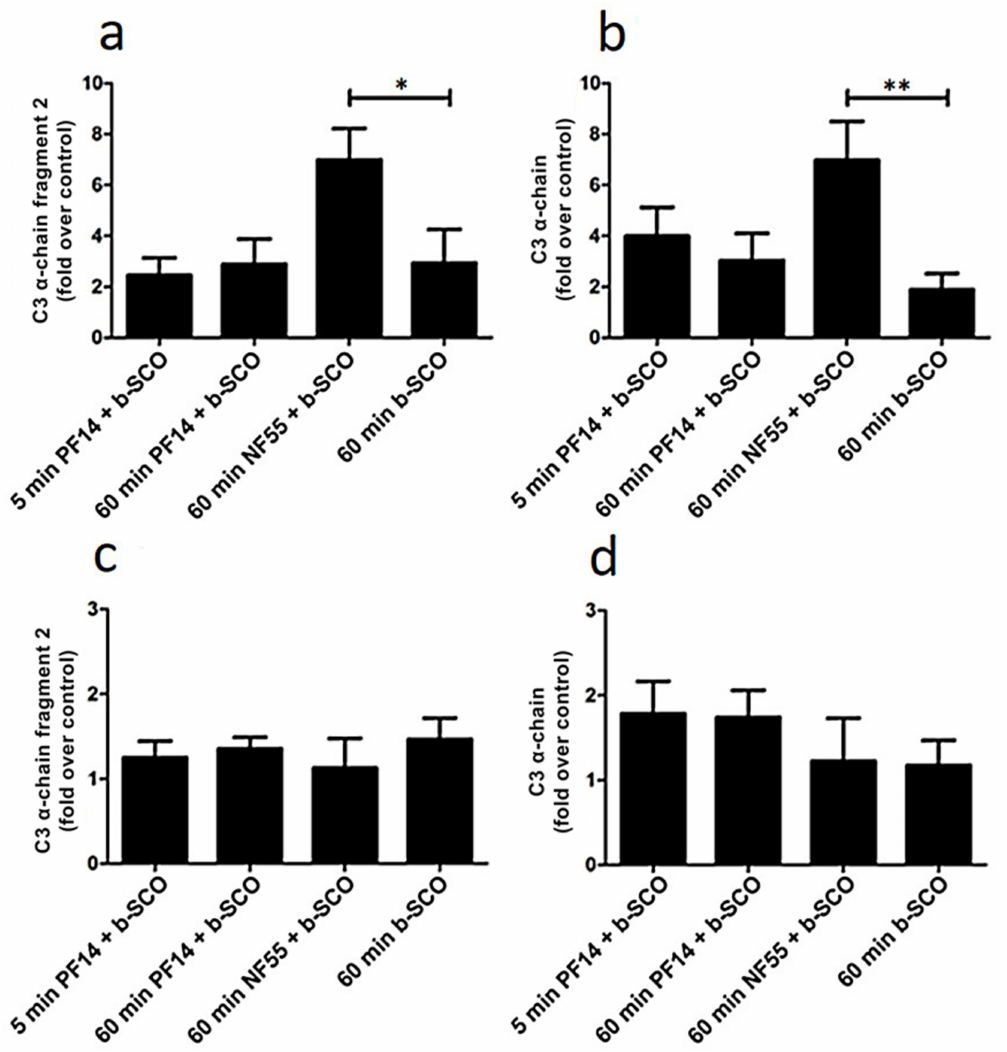
Figure 4. Level of complement component 3 (C3) in protein corona of CPP-SCO nanoparticles. CPP-SCO nanoparticles or SCO alone were bound to streptavidin on superparamagnetic beads or beads were left untreated (control) before incubation with murine serum ( a , b ) or murine plasma ( c , d ) for 5 or 60 min at room temperature. After pull-down, bound C3 and its fragments were quantified by Western blot. Data represents at least three independent experiments, ± SEM, analysed with one-way ANOVA with Dunnett’s test, * p -Value < 0.05, ** p -Value <